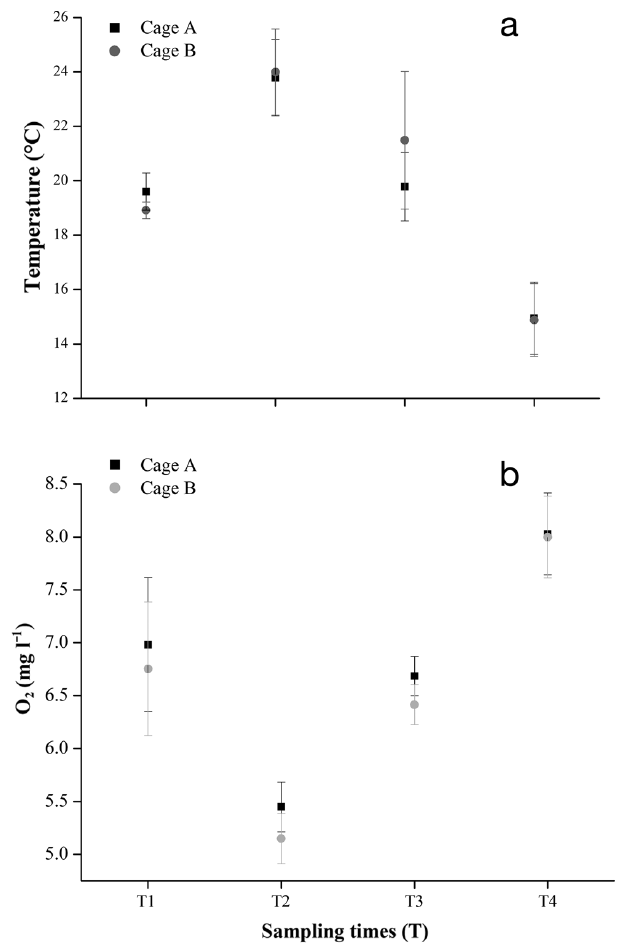
Fig. 2. Mean ± SE (a) temperature and (b) dissolved oxygen for the 4 sampling times (see Fig.